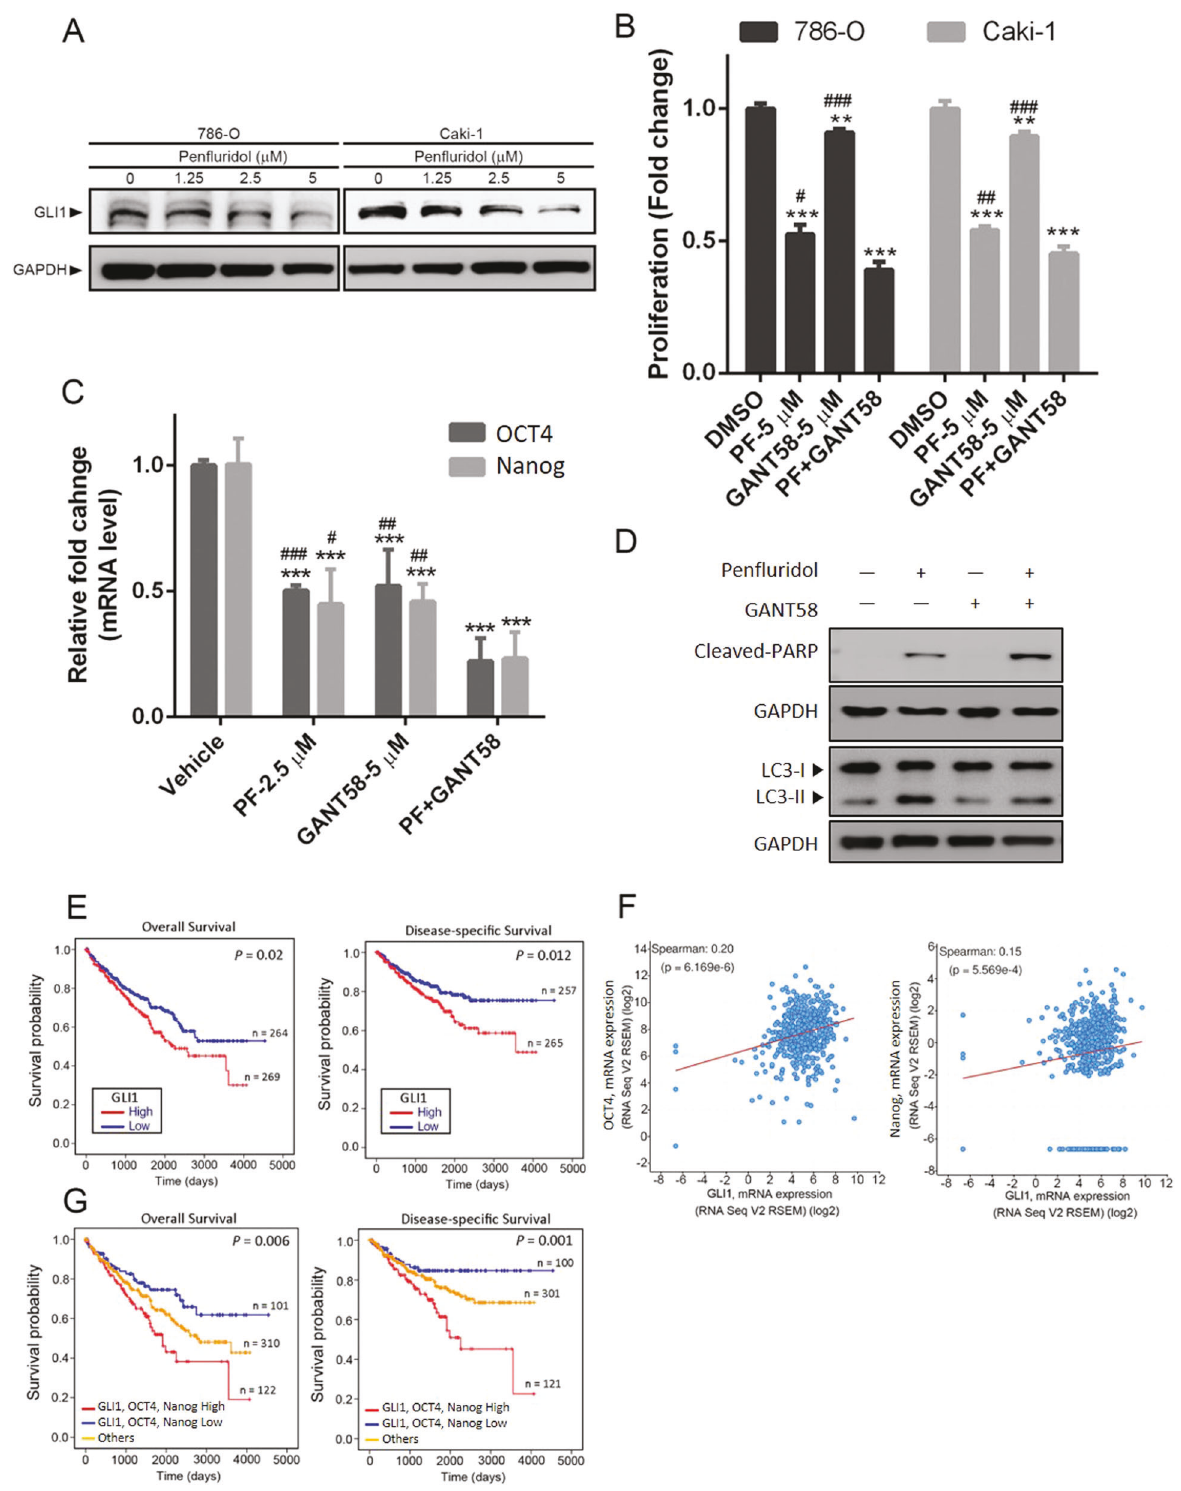
ccRCC (Fig. 5E). We further analyzed 510 ccRCC human samples using the cBioportal platform and observed that GLI1 expression was signi fi cantly correlated with OCT4 or Nanog expression (Fig. 5F). Moreover, patients with GLI1 high / OCT4 high /Nanog high ccRCC tumors had the shortest OS and DSS times compared to the other groups (Fig.